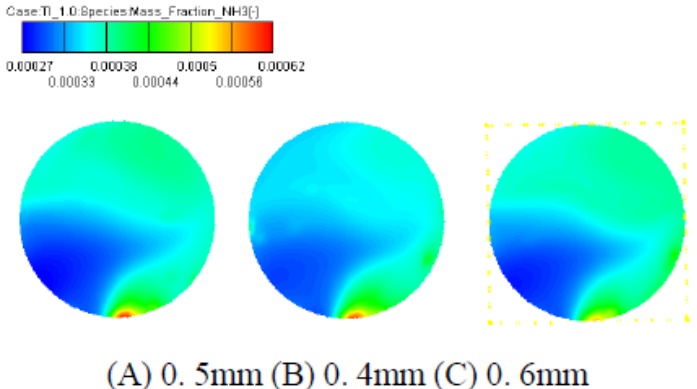
Fig. 13 Mass-fraction of NH 3 at different entry diameter.